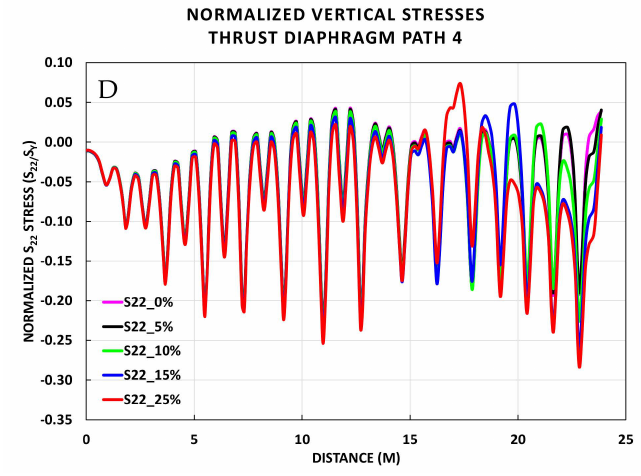
Figure 14. Calculated vertical stresses along vertical paths 1, 2, 3, and 4, on plots ( A ), ( B ), ( C ), and ( D ),